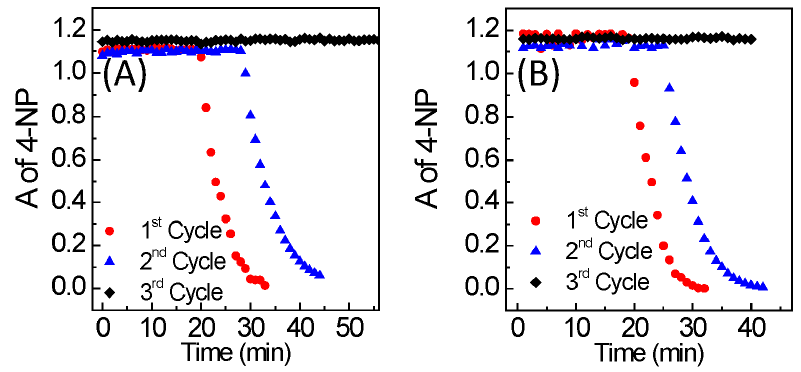
Figure 5. Recovery and reuse of AuNP-MUA with 90% surface coverage in catalysis by using ( A ) pH-triggered aggregation/redispersion method and ( B ) pH-triggered phase transformation method.